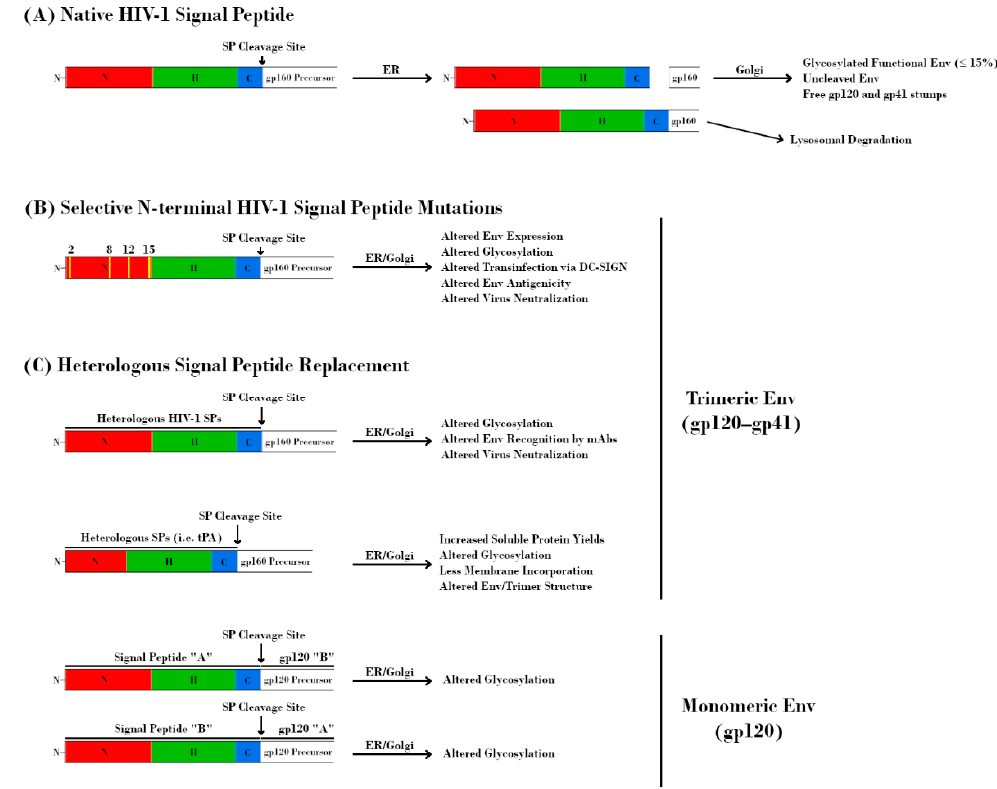
Figure 4. Effect of signal peptide (SP) modification/replacement on envelope (Env). ( A ) The HIV-1 SP is responsible for targeting the nascent glycoprotein 160 (gp160) precursor to the endoplasmic reticulum (ER) for processing. Uniquely, the SP remains attached to this protein throughout the ER and is cleaved prior to delivery of gp160 to the Golgi apparatus. Further retention of the SP results in lysosomal degradation of Env and serves as a quality control mechanism. ( B ) Mutations at specific residues within the N-terminal region of the HIV-1 SP result in alterations to Env expression, glycosylation, DC-SIGN-mediated transinfection, antigenicity, and neutralization. ( C , top) Replacement of the native HIV-1 SP with heterologous HIV-1 SPs alters glycosylation, Env recognition by monoclonal antibodies (mAbs), and virus neutralization. Replacement with non-HIV-1 SPs is a common strategy for increasing immunogen yield. However, this approach may also have detrimental effects on Env glycosylation, structure, and antigenicity. The perceived advantage of increased soluble protein yields may be offset by a higher proportion of Env immunogens with under-processed glycans due to the absence of HIV-1 SP-mediated effects on processing. ( C , bottom) The glycosylation profiles of HIV-1 glycoprotein 120 (gp120) proteins are dependent on their SPs. Transposition of SPs from HIV-1 species with different proportions of glycan types is sufficient to alter glycosylation profiles.